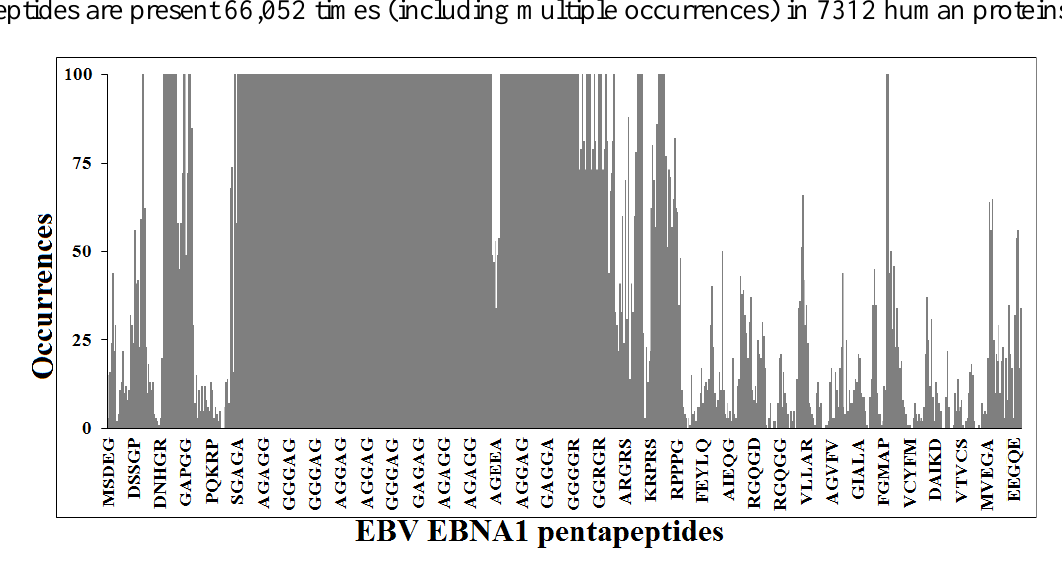
Figure 1. Pentapeptide identity platform shared between Epstein-Barr virus (EBV) Epstein-Barr nuclear antigen 1 (EBNA1) protein and the human proteome. Peptide aa sequences in one letter